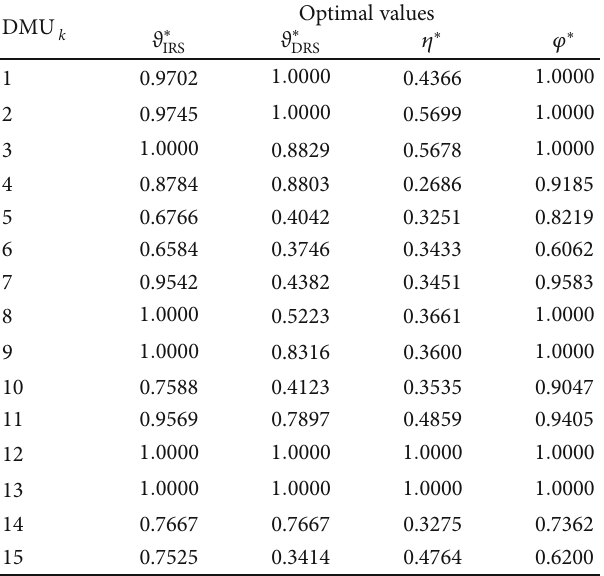
Table 2: The e ffi ciency evaluation results of di ff erent uncertain random DEA models. DMU